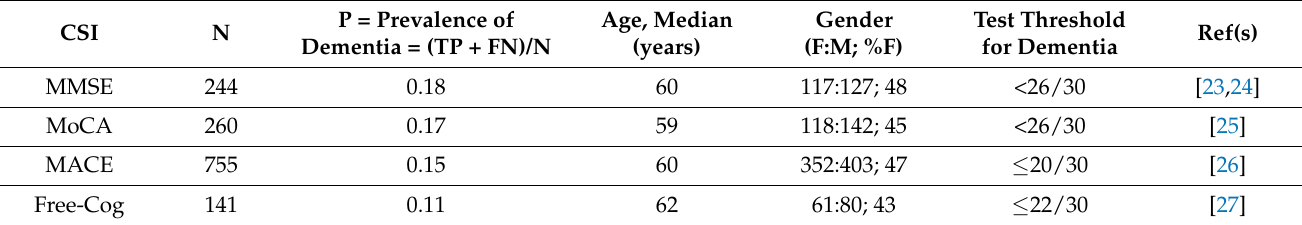
Table 1. Study demographics and test thresholds for